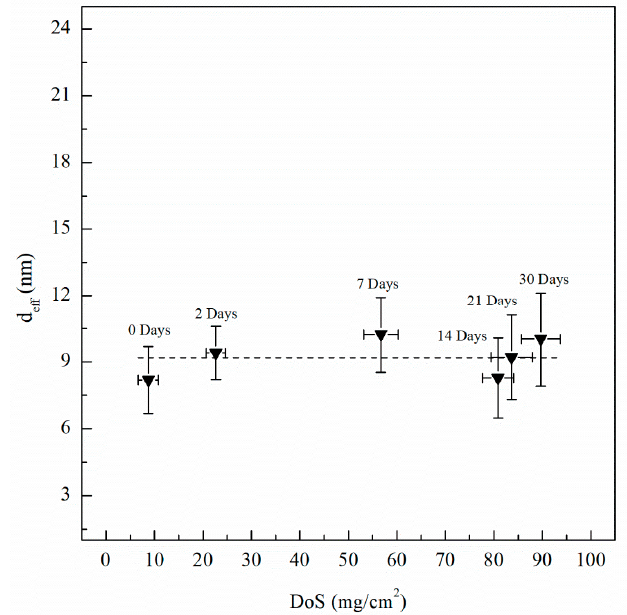
Figure 15. Passive film thickness ( d eff ) calculated using Equation (5) and C eff,f values from EIS fitting data. Error bars represent standard deviation from the mean.